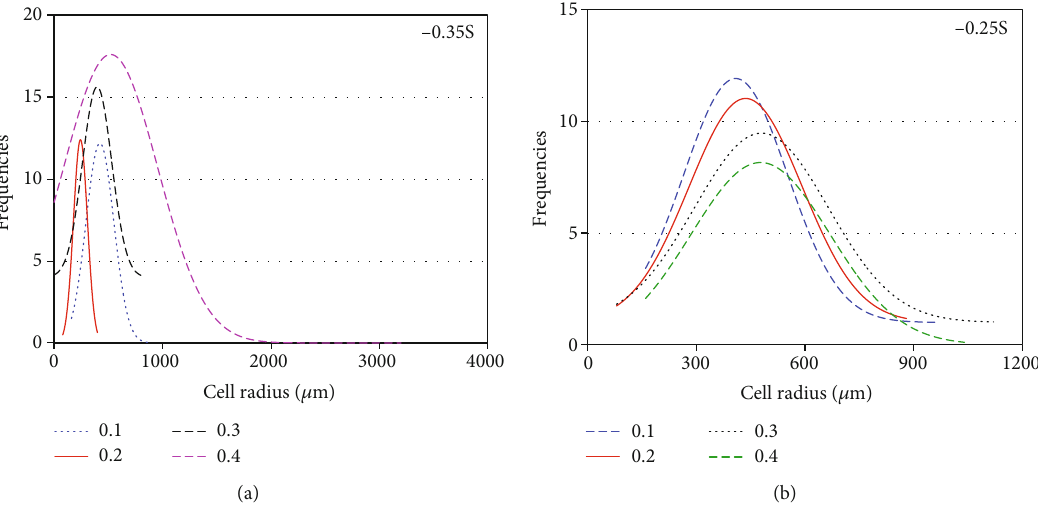
Figure 10: Dependence of the pore size distribution on the triethylamine